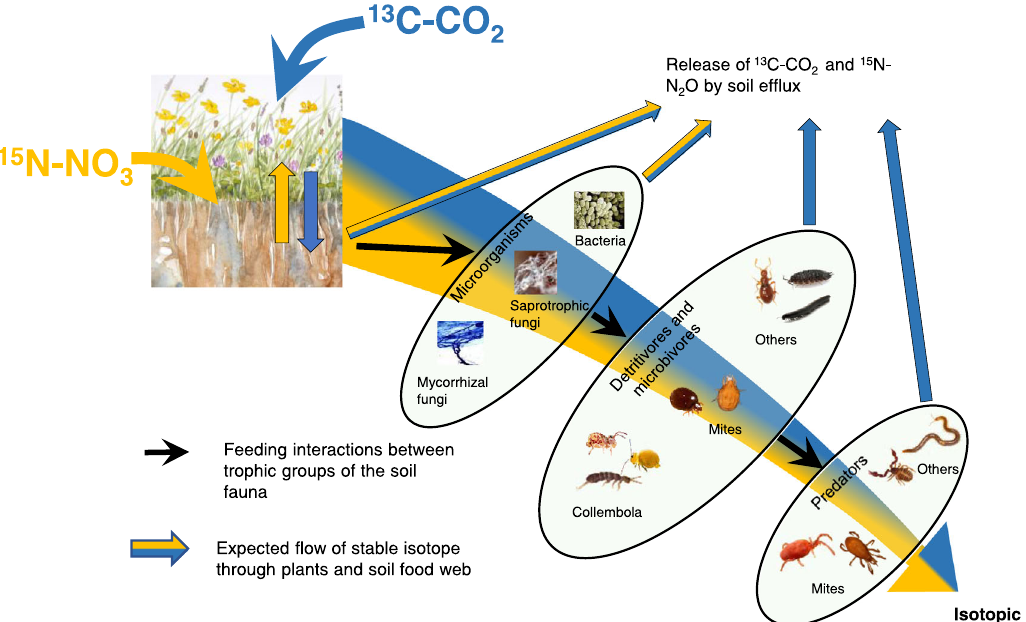
Fig. 1 | The expected paths of C and N tracers in the plant-soil system. Con- ceptual diagram of the expected fl ow of 13 C (blue) and 15 N (yellow) through plants and soil trophic groups. The fi gure represents the groups we analysed for their 13 C and 15 N content, hence the simpli fi cation of the food web. The ellipses represent the trophic groups, and although interactions within